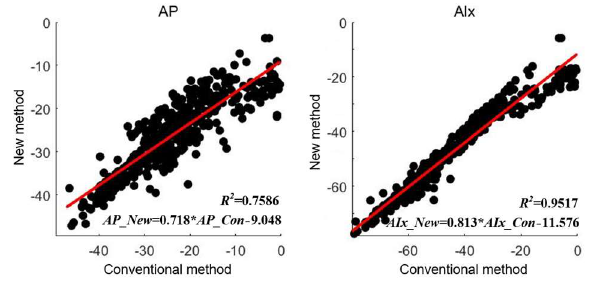
Figure 12. Relationship between two